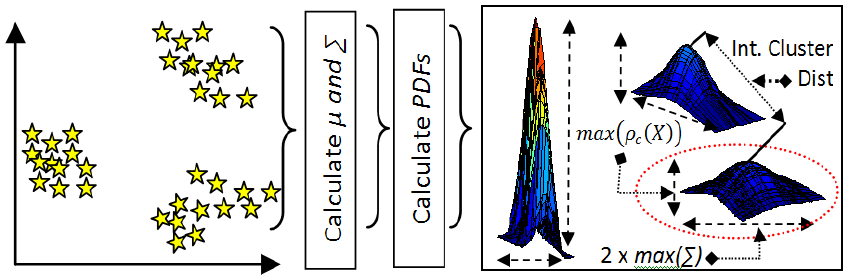
Figure 12. Steps of the multivariate probability density function’s cluster distribution factor (MPDFCDF) cluster evaluation method.